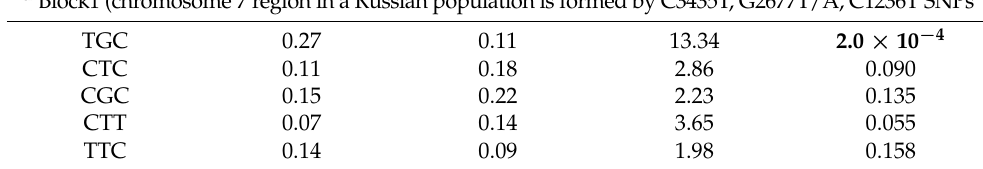
Table 5. Haplotype association analysis of SNPs from MDR1 gene with response to cyclosporine therapy at 3 months.